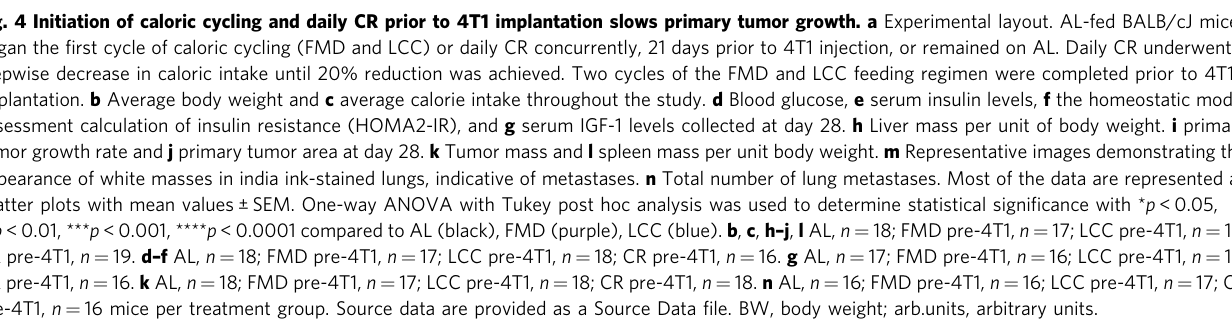
Fig. 4 Initiation of caloric cycling and daily CR prior to 4T1 implantation slows primary tumor growth. a Experimental layout. AL-fed BALB/cJ mice began the fi rst cycle of caloric cycling (FMD and LCC) or daily CR concurrently, 21 days prior to 4T1 injection, or remained on AL. Daily CR underwent a stepwise decrease in caloric intake until 20% reduction was achieved. Two cycles of the FMD and LCC feeding regimen were completed prior to 4T1 implantation. b Average body weight and c average calorie intake throughout the study. d Blood glucose, e serum insulin levels, f the homeostatic model assessment calculation of insulin resistance (HOMA2-IR), and g serum IGF-1 levels collected at day 28. h Liver mass per unit of body weight. i primary tumor growth rate and j primary tumor area at day 28. k Tumor mass and l spleen mass per unit body weight. m Representative images demonstrating the appearance of white masses in india ink-stained lungs, indicative of metastases. n Total number of lung metastases. Most of the data are represented as scatter plots with mean values ± SEM. One-way ANOVA with Tukey post hoc analysis was used to determine statistical signi fi cance with * p <